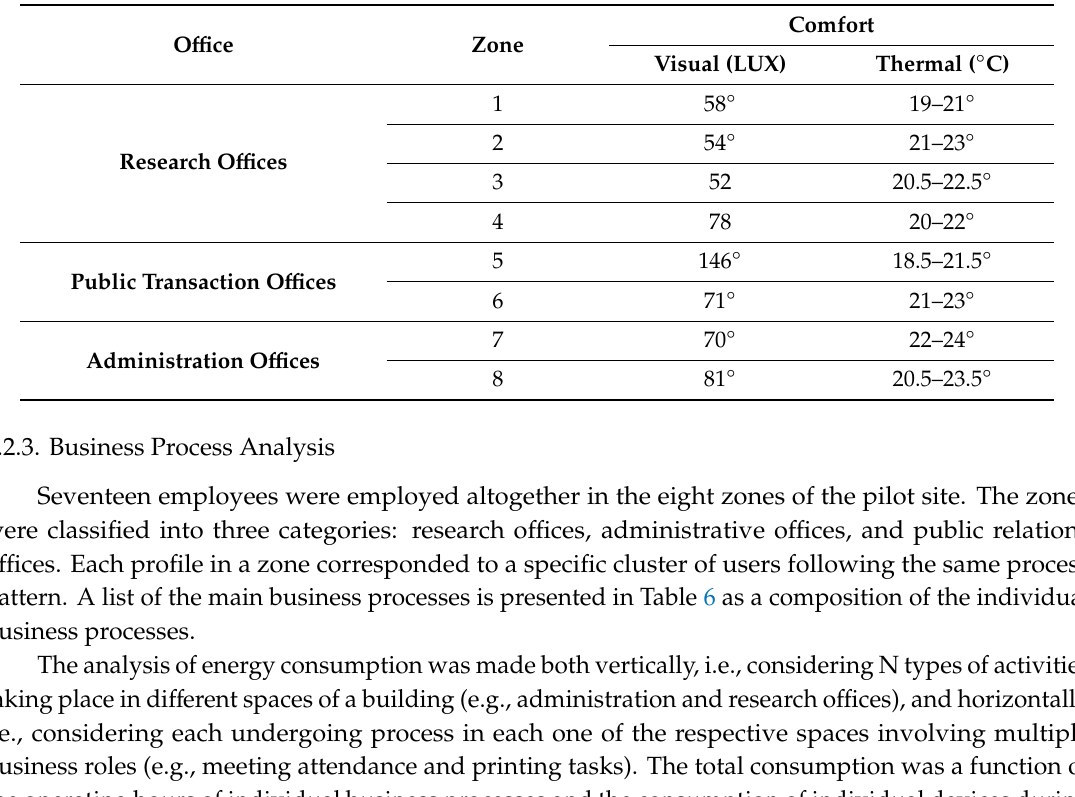
Figure 11. HVAC consumption—indicative microscopic analysis.